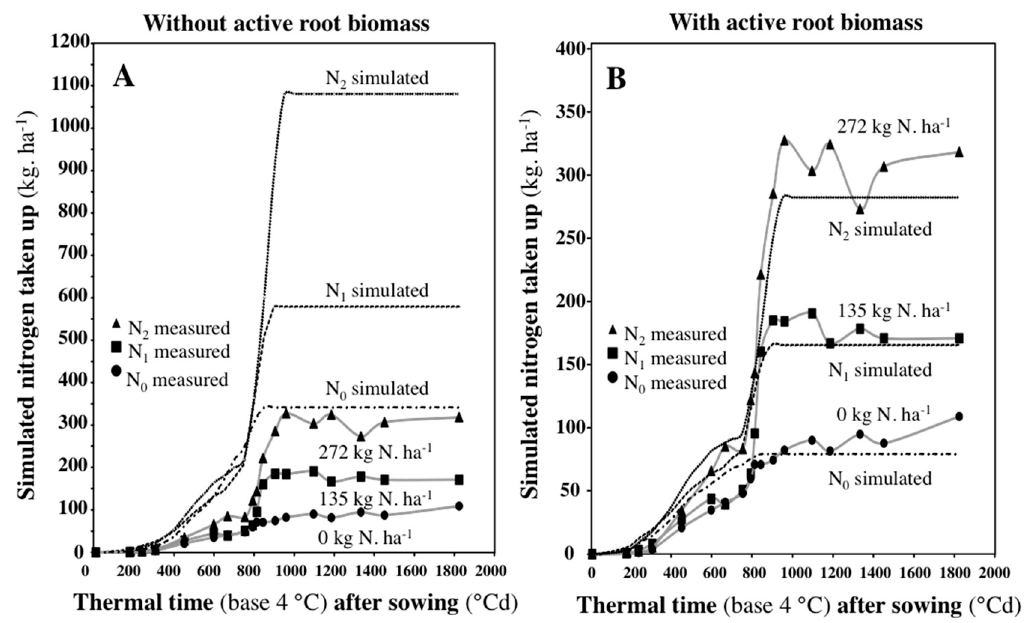
Figure 9. Simulated versus measured outputs of the total nitrogen taken up by a winter oil seed rape crop ( B. napus , cultivar ‘Capitol’) under field conditions for three levels of N fertilization. ( A ) The simulated values are obtained without using active root biomass (ARB). ( B ) The simulated values are obtained after using ARB to estimate the active root biomass. The values simulated by the model are indicated by a dotted line and the real values measured in the field are indicated by simple symbols and a full line. Data used to run the model came from the INRA-database (https://ecosys.versailles-grignon.inra.fr/ceres_mais/base/welcome.html